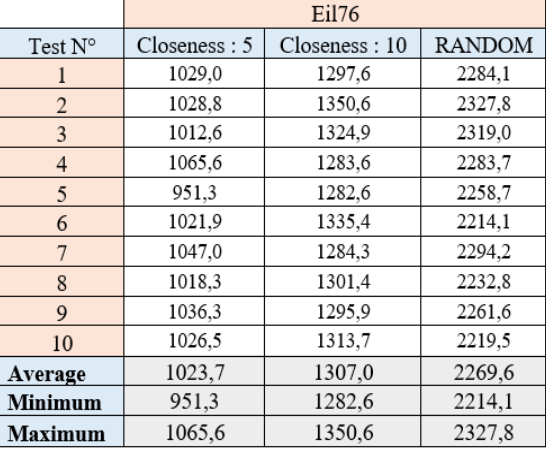
Table2: Summary of simulation results for the effectiveness of initialization Eil76